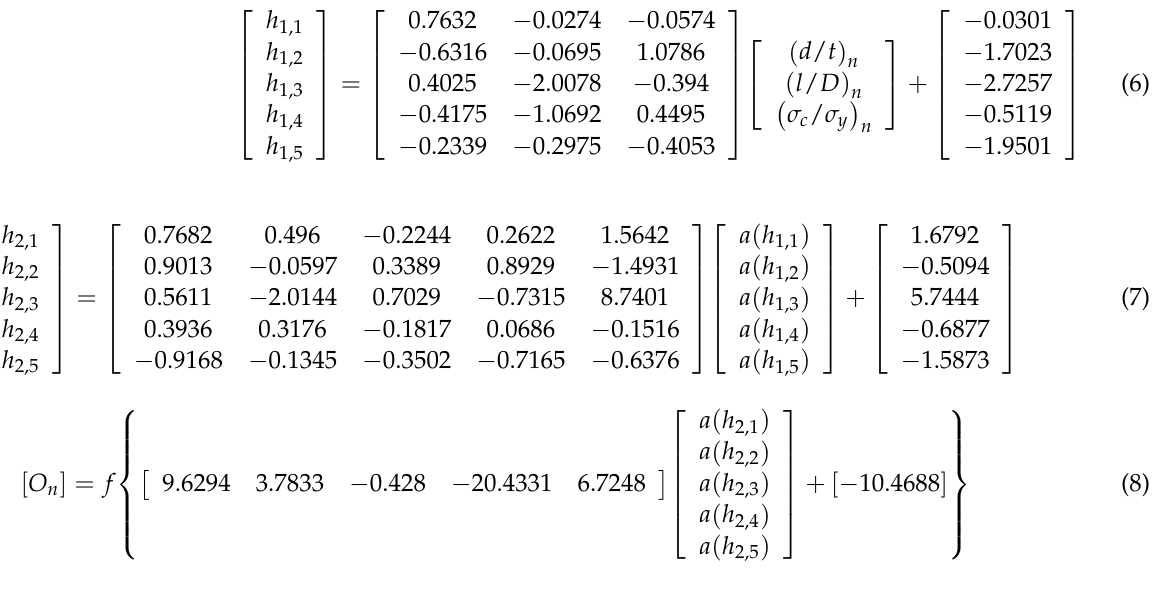
Figure 13. Architecture of FFNN model employed. The connections between the input, output, hidden neurons, and its weights and biases can be expressed in the mathematical form of Equations (6)–(8). After training the ANN with all the datasets, the weights and biases were adjusted for output predictions with the lowest error. The weights and biases of the network were extracted and used in Equations (6)–(8), and they are expressed as follows: